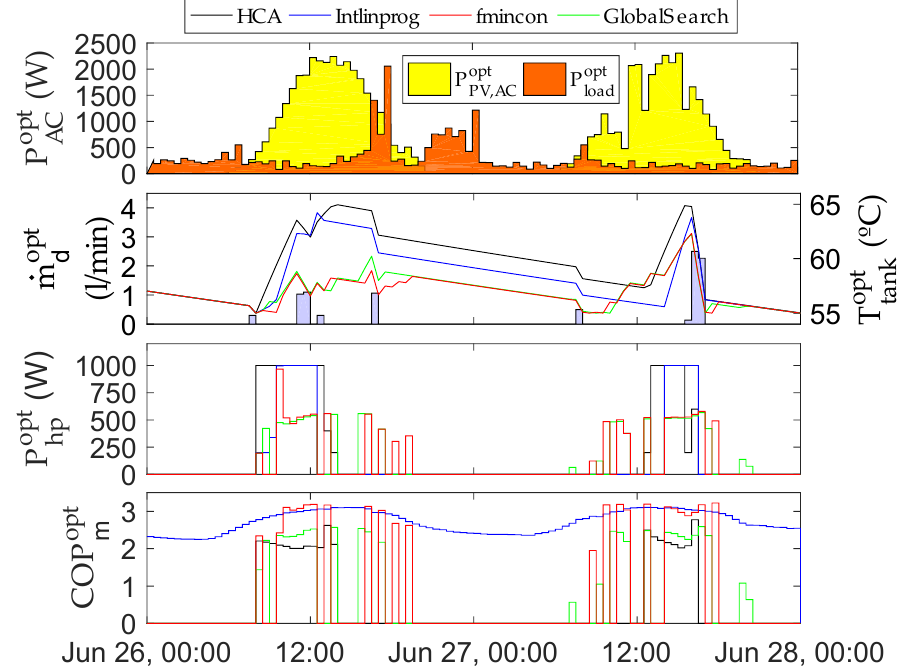
Figure 4. AC photovoltaic production ( P opt ( T opt ), domestic hot water consumption ( ˙ m opt tank coefficient of performance ( COP opt m ) profiles yielded by heuristic control algorithm (HCA), intlinprog , fmincon and GlobalSearch for a 48h time horizon in the summer.